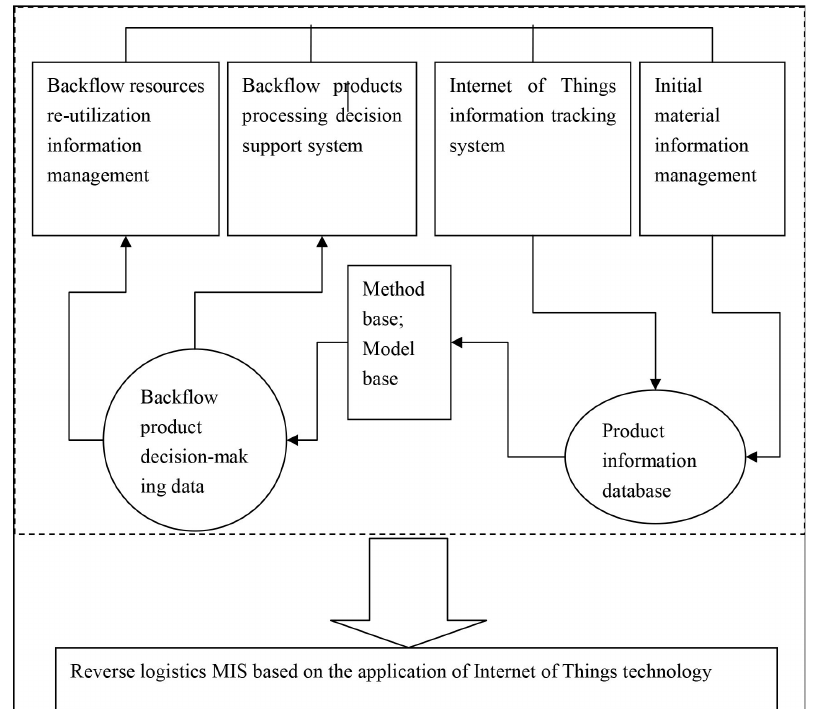
Figure 1. Reverse logistics MIS based on the application of Internet of Things